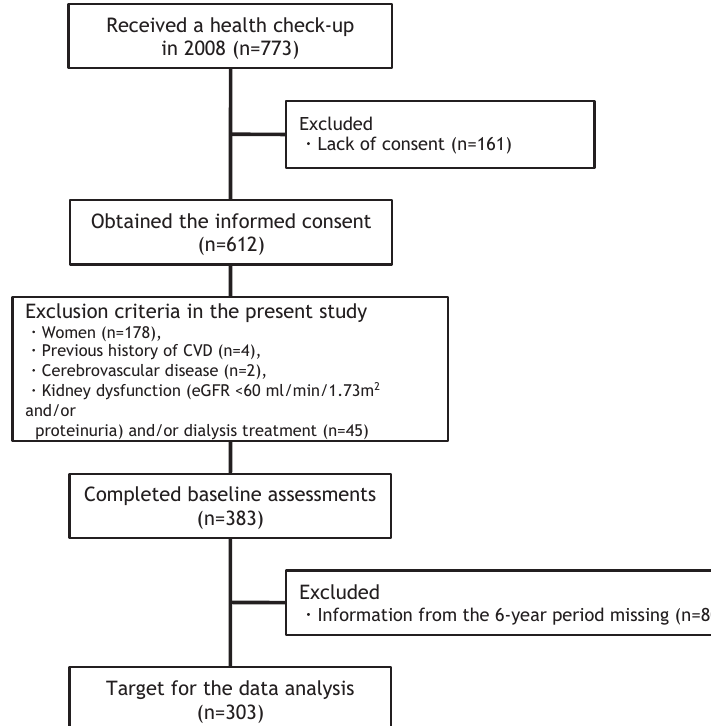
Figure 1. A fl ow-chart of the participants associated with the present